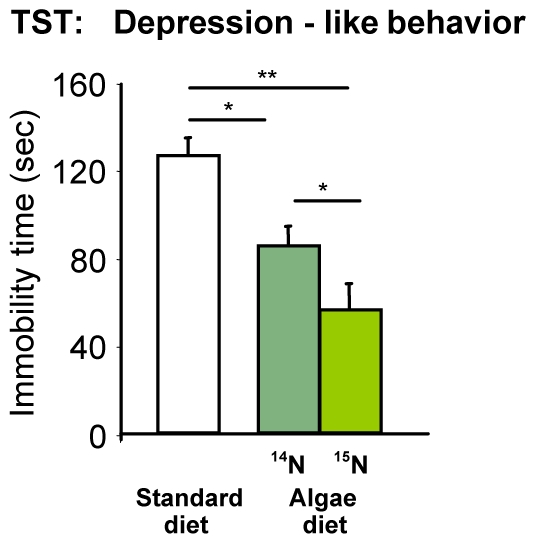
Depression-like behavior of HAB animals in the tail suspension test (TST).Animals fed with blue-green algae diet hat a strongly reduced immobility, indicating depression-like behavior, compared to standard fed animals. This effect was even more pronounced in animals fed with the 15N isotope (*p<0.05; **p<0.01).